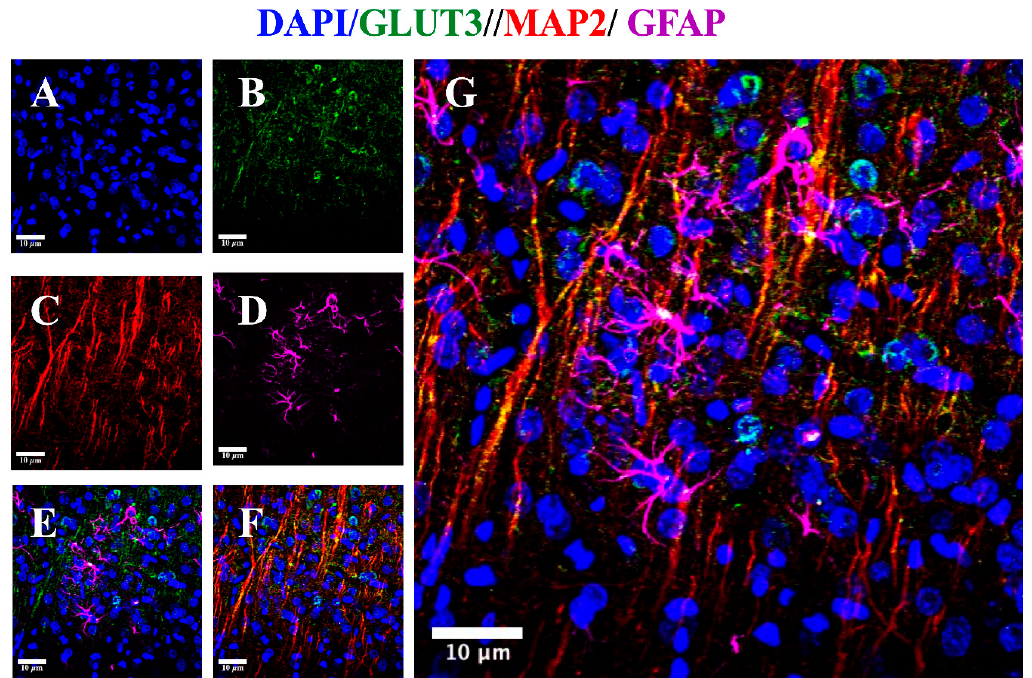
Figure 4. Glucose transporter 3 (GLUT3) expression in neurons and astrocytes in the control brain. Brain coronal sections were obtained from control rats and analyzed by immunofluorescence. Images were acquired on a Nikon Ti Eclipse inverted confocal microscope using a 20x objective lenses. ( A ) Nuclei (blue), 4’, 6-diamidino-2-phenylindole (DAPI) was used to detect nuclei, ( B ) GLUT3 (green), ( C ) Neuronal specific protein: the microtubule-associated protein 2 (MAP2, red), ( D ) Astrocyte specific protein: glial fibrillary acid protein (GFAP, violet), ( E ) Low expression of GLUT3 in GFAP positive cells, ( F ) High expression of GLUT3 in MAP2 positive cells, and ( G ) Merge of DAPI, GLUT3, MAP2 and GFAP signal, showing predominant expression of GLUT3 in neurons.